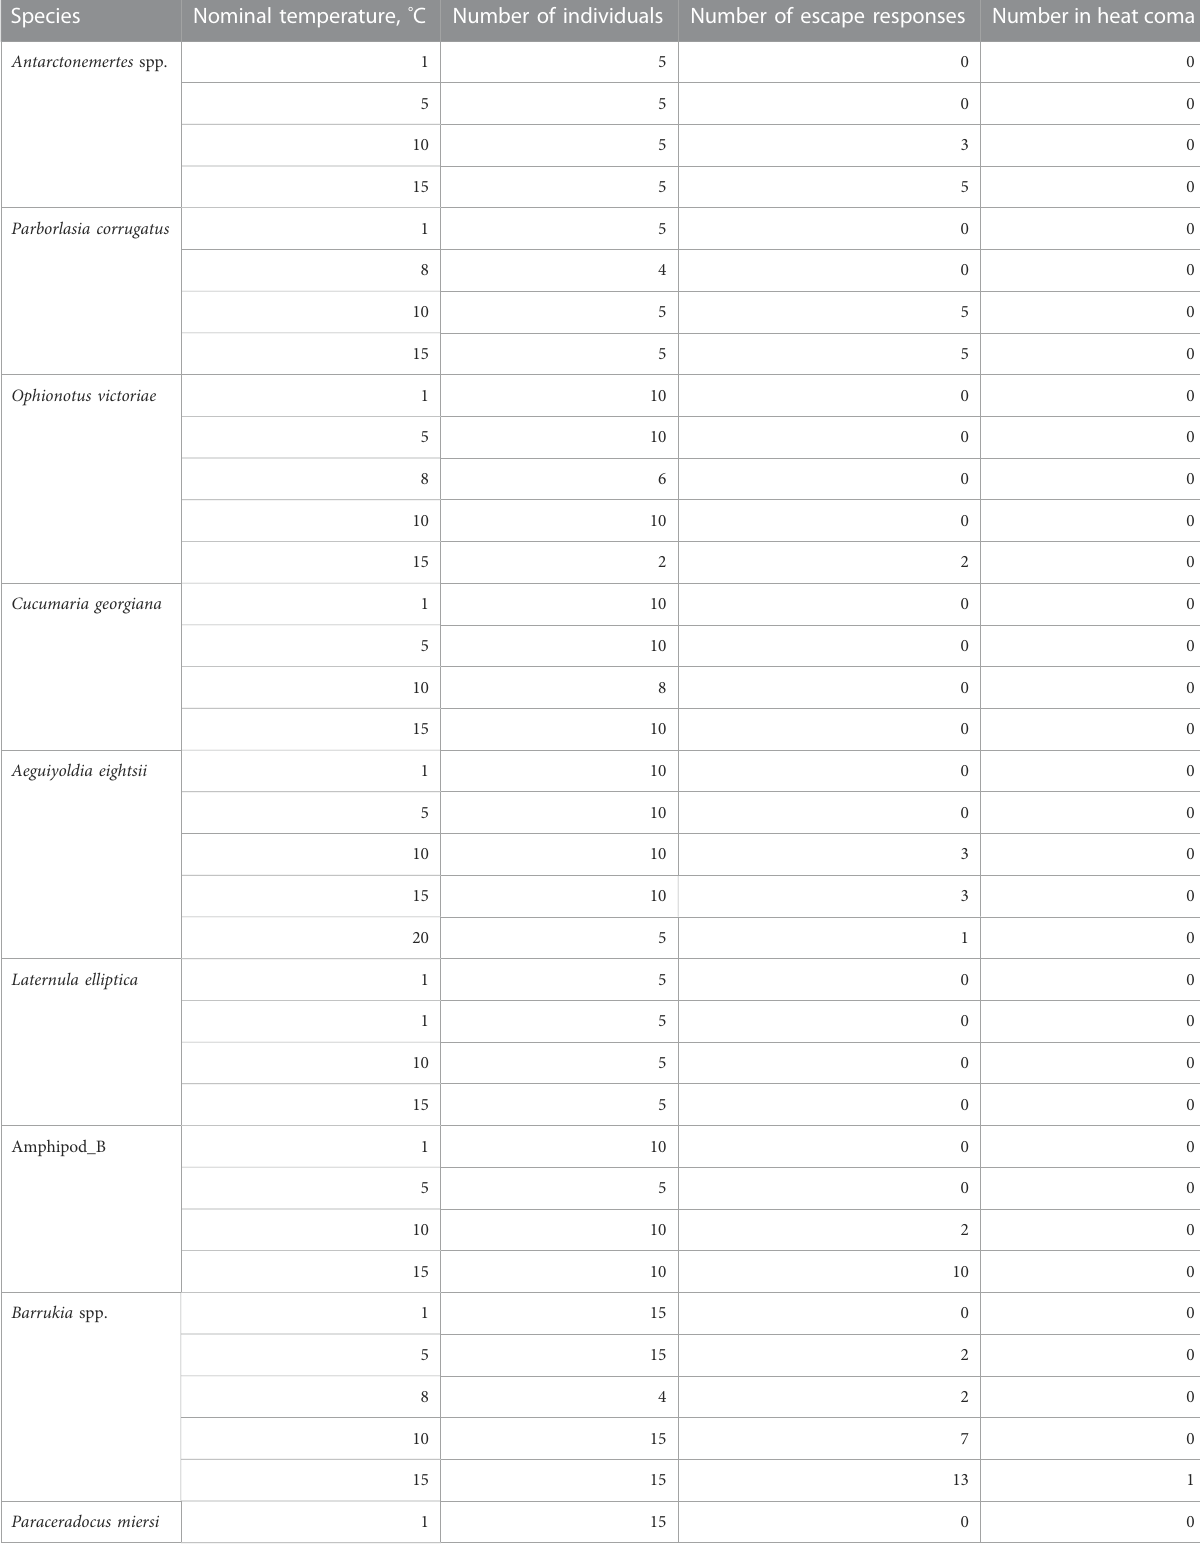
TABLE 1 Sample size of each species at each temperature. Species Nominal temperature, ° C Number of individuals Number of escape responses Number in heat coma Antarctonemertes